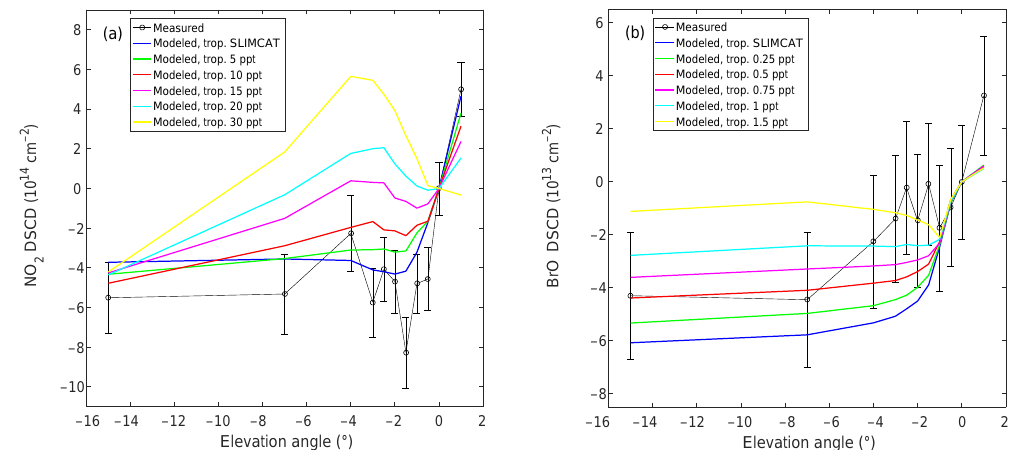
Figure 15. Sensitivity study to determine tropospheric (a) NO 2 and (b) BrO mixing ratios. The black curve shows the NO 2 and BrO SCD from an elevation scan performed during the first descent of SF3-2013. These SCDs are compared to various forward calculations based on Tomcat/Slimcat results for this specific flight segment and various assumed tropospheric NO 2 and BrO mixing ratios. Within the uncertainty of the observations, the tropospheric NO 2 can be determined to be below ∼ 10ppt, while BrO is around 0.5 ± 0.5ppt and possibly somewhat larger ( ≤ 1.5ppt) just below the flight